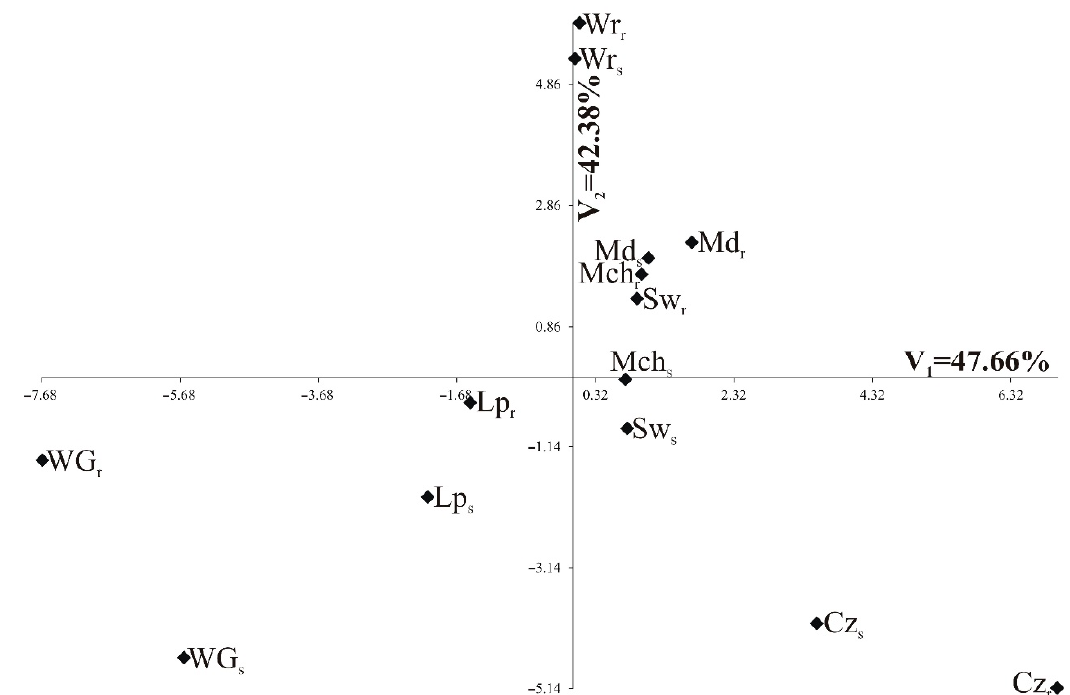
Figure 9. Distribution of seven sites where the competition of winter wheat (WW) was tested against bentgrass with multiple herbicide resistance (RM) or susceptible (S) in 2018–2019, based on five biological parameters of WW, in the space of the first two canonical variables (V1 and V2). Sites: Lp—Lipnik, Mch—Mochełek, WG—Winna G ó ra, Cz—Czesławice, Sw—Swojczyce, Wr—Wrocław, Md—Mydlniki. Subscript “r” denotes the competition of WW with RM and the subscript “s” with S.